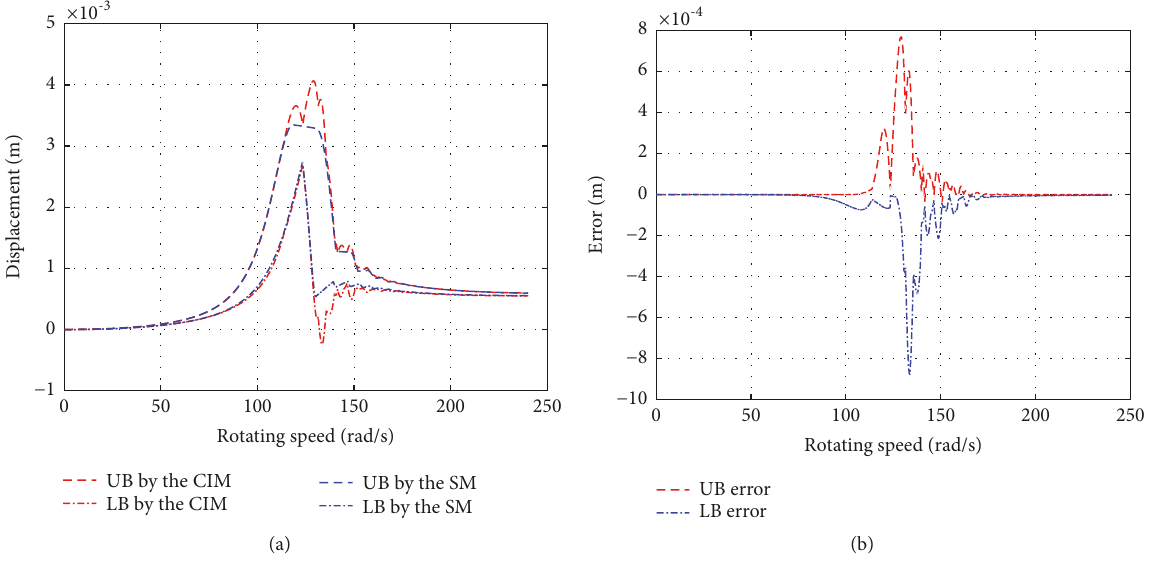
Figure 5: (a) Transient response of the rotor with uncertain disk mass and (b) calculation